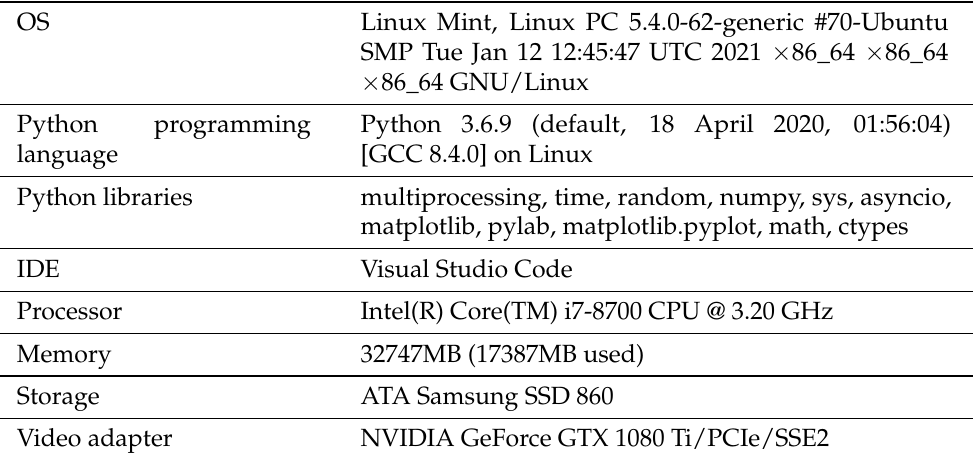
Table 3. Hardware and software used in the experiment.